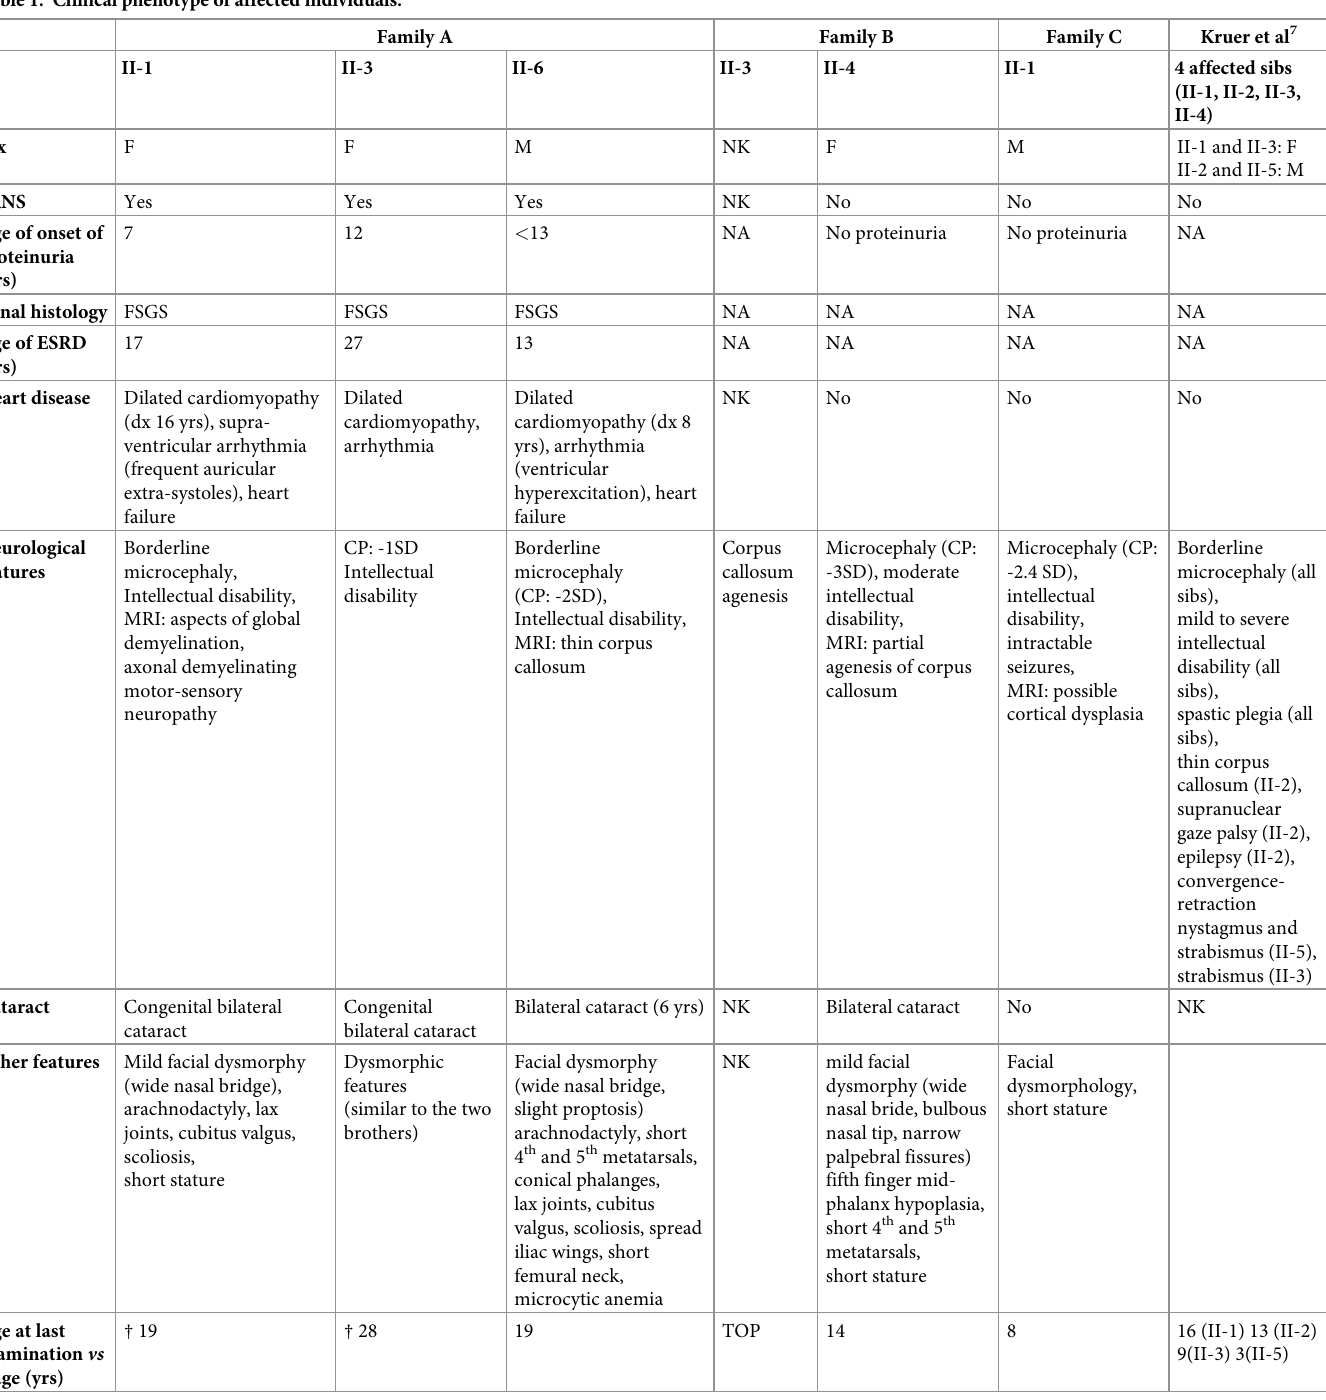
Table 1. Clinical phenotype of affected